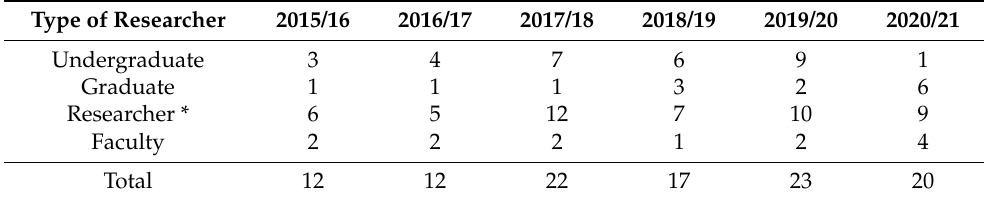
Table 2. HeNReG Participants by Type of Researcher in Relation to Academic